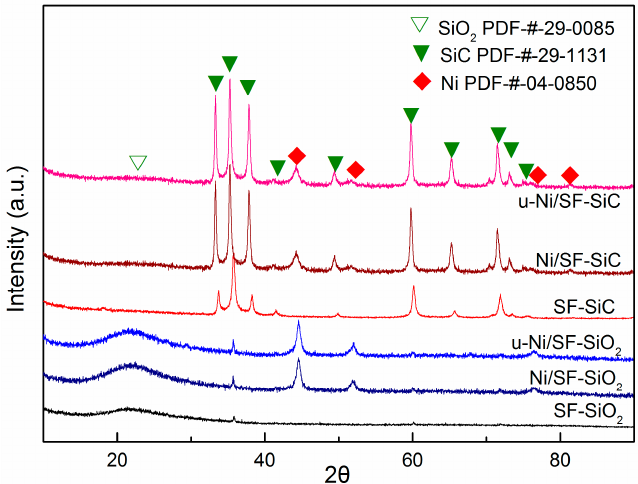
Figure 2. Wide ‐ angle XRD patterns of the support and the catalysts SF ‐ SiO 2 , Ni/SF ‐ SiO 2 , u ‐ Ni/SF ‐ SiO 2 , Figure 2. Wide-angle XRD patterns of the support and the catalysts SF-SiO 2 , Ni/SF-SiO 2 , u-Ni/SF-SiO 2 , SF ‐ SiC, Ni/SF ‐ SiC, u ‐ Ni/SF ‐ SiC. SF-SiC, Ni/SF-SiC, Table 2. Physical and chemical properties of the catalysts and supports.